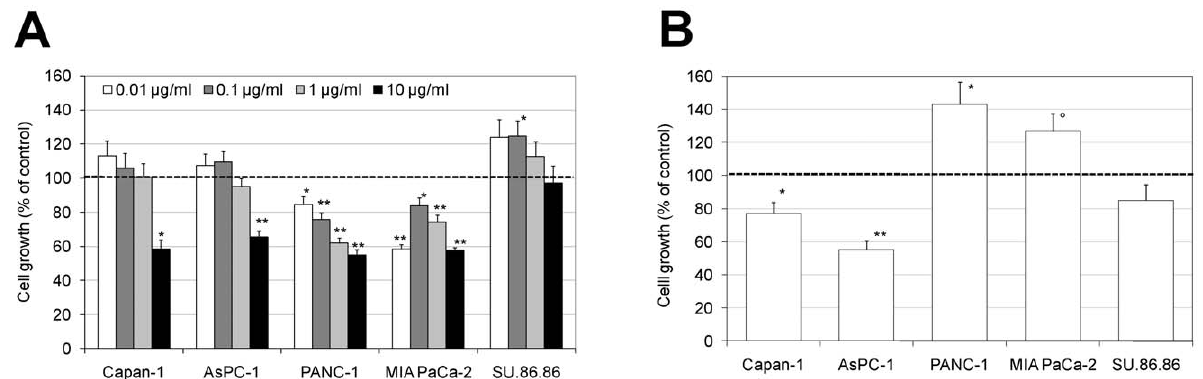
Figure 1. Effects of exogenous TNC on pancreatic cancer cell growth. (A) Cells were grown for 72 hours in serum free medium containing different concentrations of TNC (0.01, 0.1, 1 and 10 m g/ml). (B) Cells were grown for 72 hours in serum free medium onto TNC coated plates (1 m g/ cm 2 ). Growth was determined with MTT assay. Data are calculated as mean + / 2 s.e.m. of three experiments and are expressed as percentage compared to the untreated controls ( u p , 0.05, *p , 0.01, **p , 0.001, Students two-tailed t test).